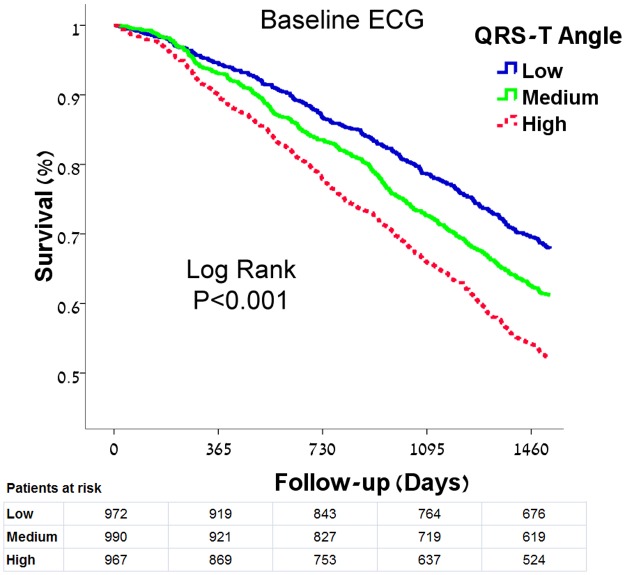
Kaplan Meier survival analysis according to baseline QRS-T angle category stratified by gender.The tertile QRS-T angle percentiles were 40° and 103° in women and 51° and 125° in men. The estimated cumulative survival rate at the median follow-up time was reduced with increasing baseline QRS-T angle category; 67.9±1.5% vs. 61.2±1.5% vs. 52.1±1.6%, P<0.001.